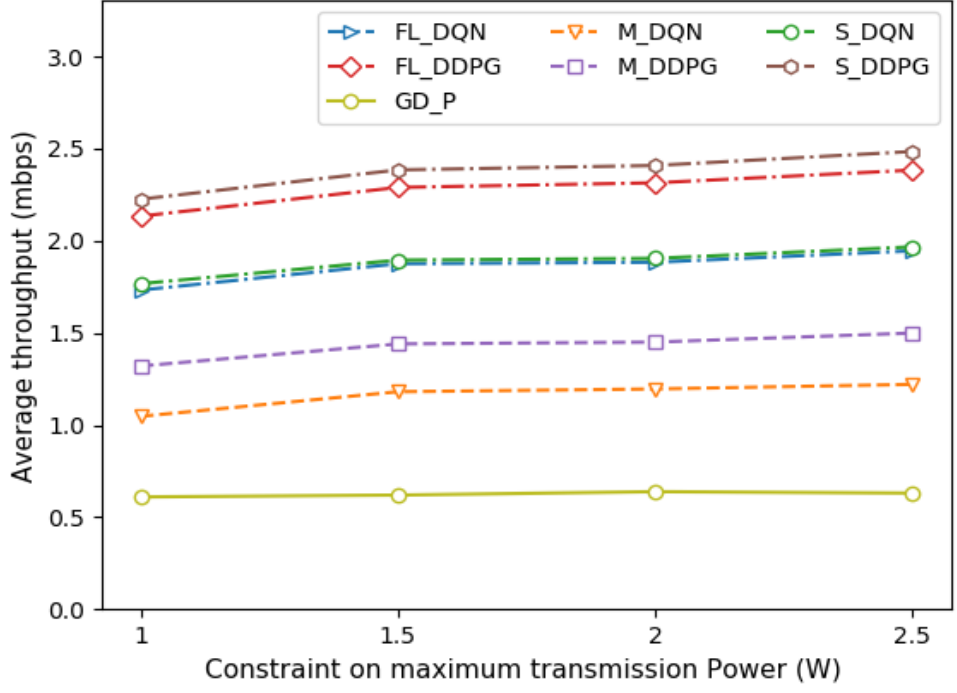
Figure 7. Comparison of average throughput under different power constraints.